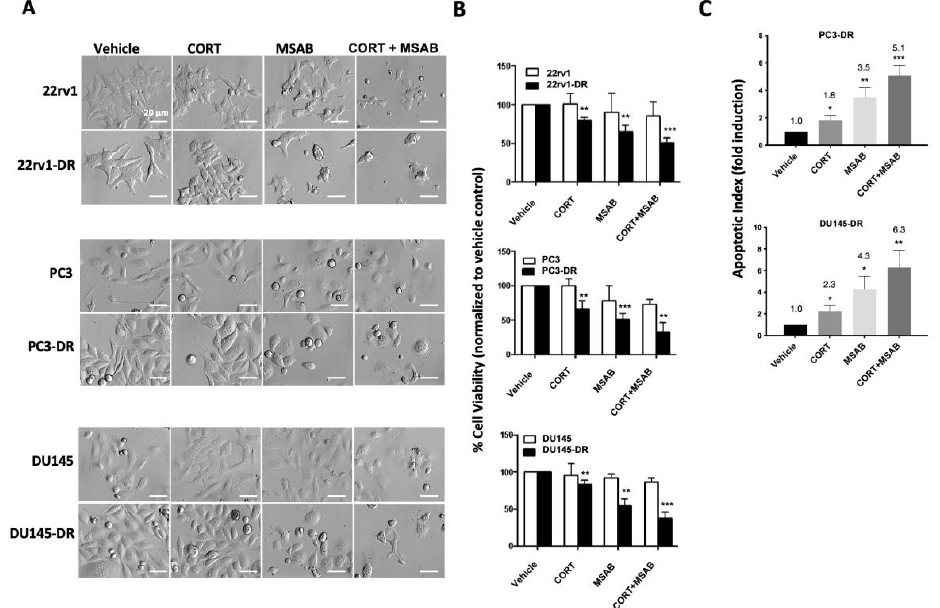
Figure 8. Co-inhibition of GR and β -catenin re-sensitizes DTX-resistant PCa cells to docetaxel. ( A ) Hoffman modulation microscopy (800 × ) images of DTX-sensitive and DTX-resistant 22rv1, PC3, and DU145 cells treated with CORT-108297 (CORT, 1 µ M), MSAB (1 µ M), or CORT-108297 plus MSAB (CORT + MSAB, 1 µ M each) for 72 h in adherent cultures. ( B ) Cell viability following treatments was assessed using MTT assays. DMSO was used for vehicle control. ( C ) Apoptotic index (fold induction of apoptosis) was determined by flow cytometry using Annexin V and 7AAD for PC3-DR and DU145-DR cells treated with the GR and β -catenin inhibitors . DTX-resistant cells, but not sensitive cells, were cultured throughout the treatment in medium containing 10 nM DTX. All treatments were done in cells cultured in media supplemented with CS-FBS and 10 nM dexamethasone. Data are representative from 3 independent experiments and represented as mean ± SEM. * p < 0.05, ** p < 0.01, *** p < 0.001. The scale bar for all images is set at 20 µ